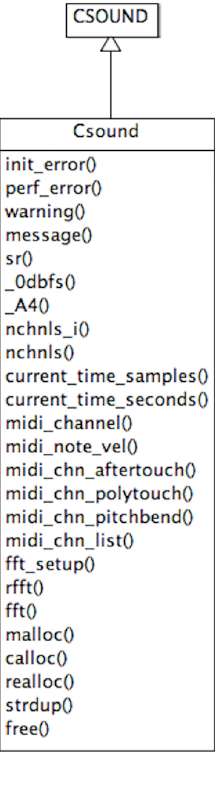
Figure 2. The Csound engine class, derived from the opaque C structure CSOUND